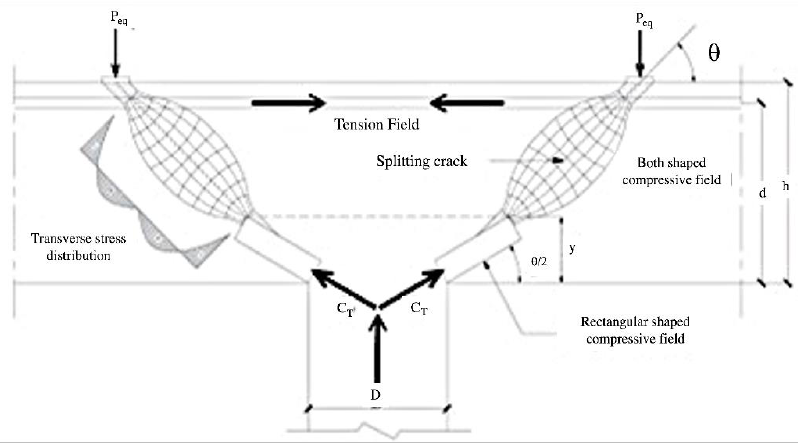
Figure 9. Force trajectories in punching cone zone.